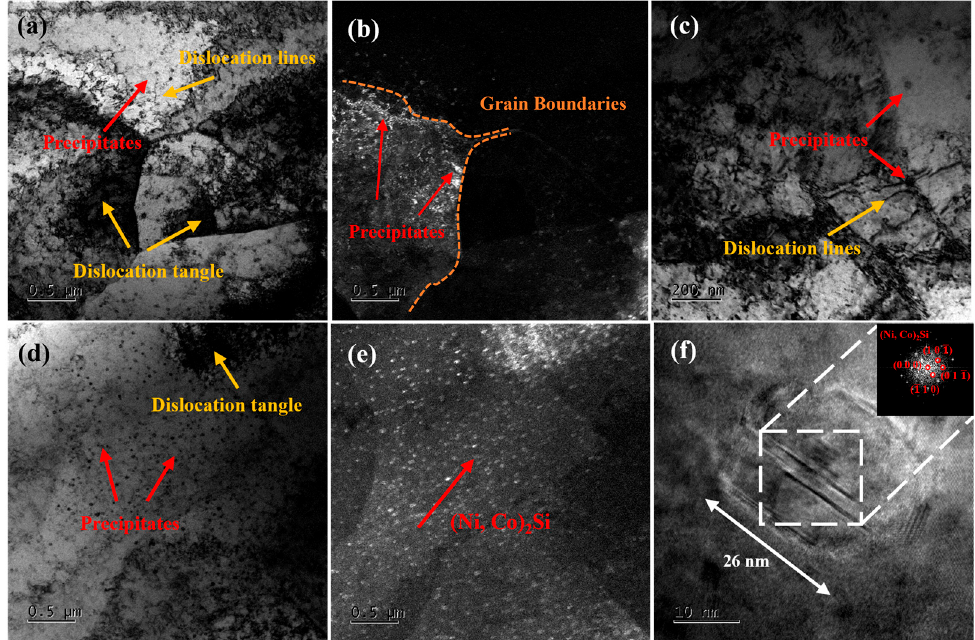
Figure 3. TEM and HRTEM images of the new type of Cu-1.1–Ni-0.7–Co-0.45–Si-0.3Cr alloy deformed at 600 °C and 0.01 s − 1 . ( a ) Bright-field TEM image, ( b ) dark-field TEM image of ( a ), ( c ) bright-field TEM image, ( d ) bright-field TEM image of precipitates, ( e ) dark-field TEM image of precipitates, ( f ) HRTEM image and corresponding FFT pattern of a (Ni, Co) 2 Si particle.